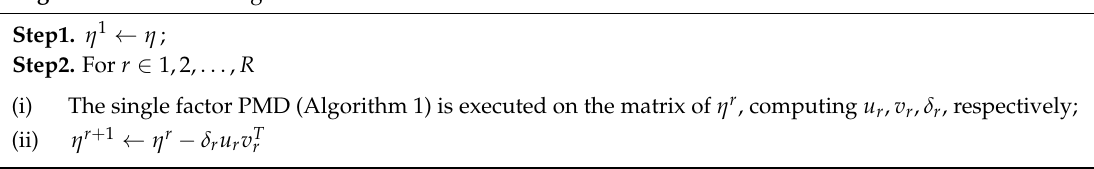
Algorithm 2. Calculating the k factor of